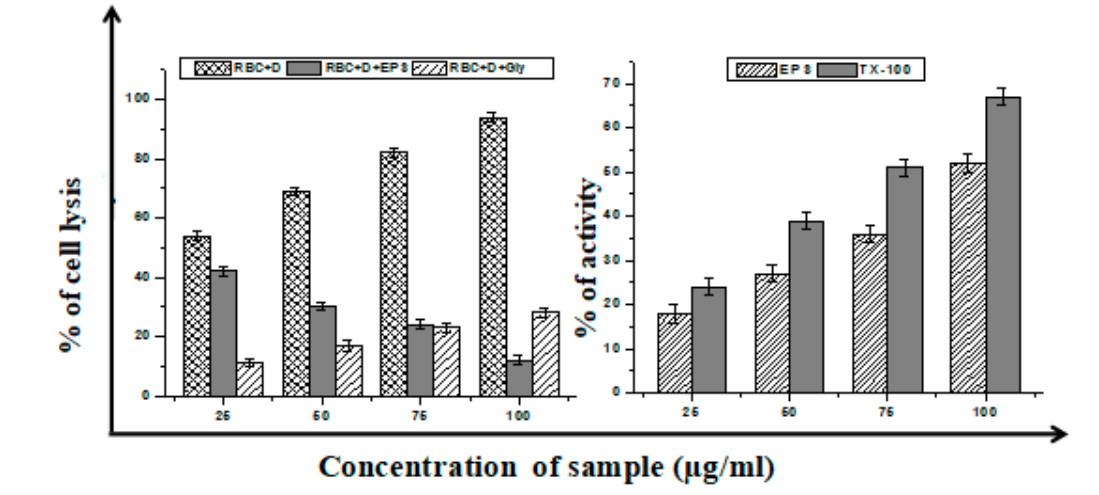
Figure 8. Cell-membrane protection and bio-surfactant activity of Halococcus sp. AMS12.